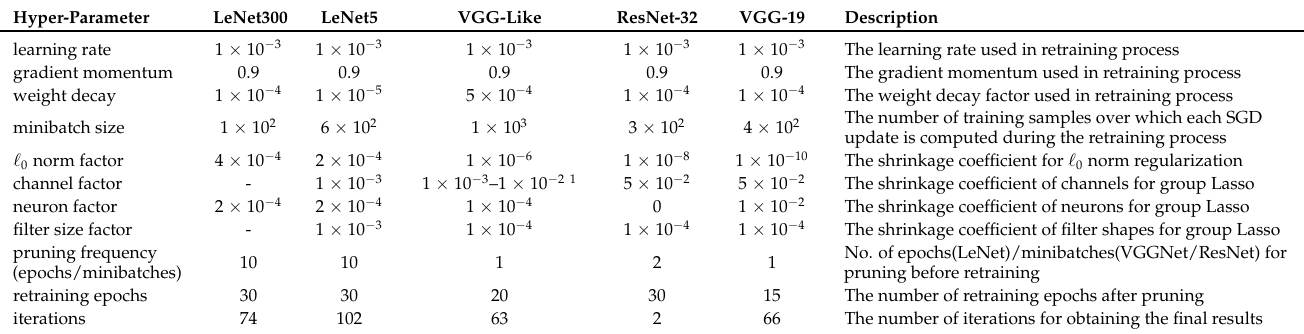
Table A1. List of hyper-parameters and their values(“-” denotes “not